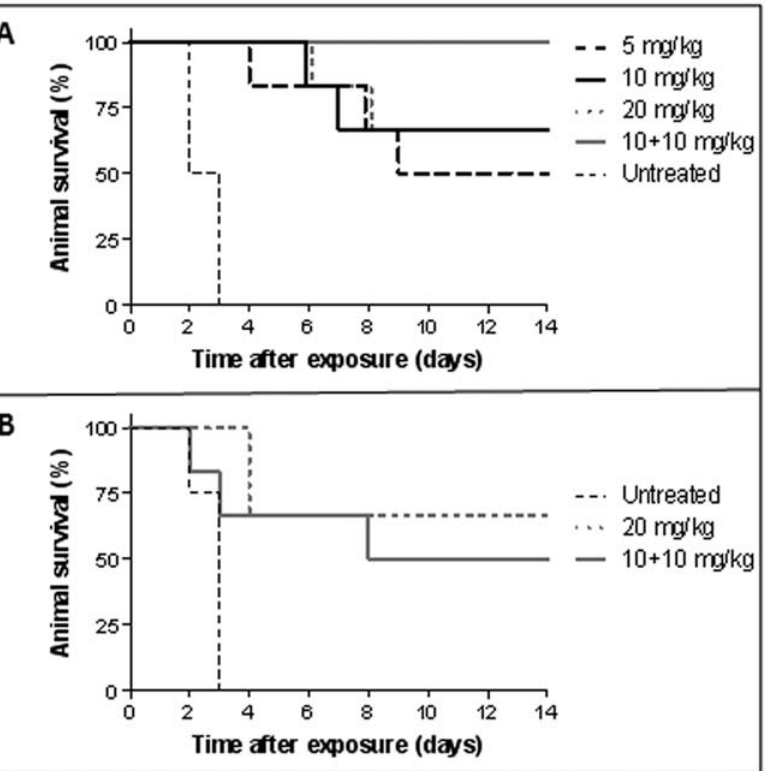
Figure 6. Protection of guinea pigs against anthrax infection. (A) Female Hartley guinea pigs (n=6 for each group) were i.m. administered with the indicated doses of cAb 29, followed by s.c. challenge with 40LD 50 of B. anthracis Vollum spores 14 hrs later. (B) 30 days after the first challenge, surviving animals from groups 20 and 10 + 10 mg/kg were re-challenged with the same dose (40LD 50 ), and survival was then monitored for another 14 days.